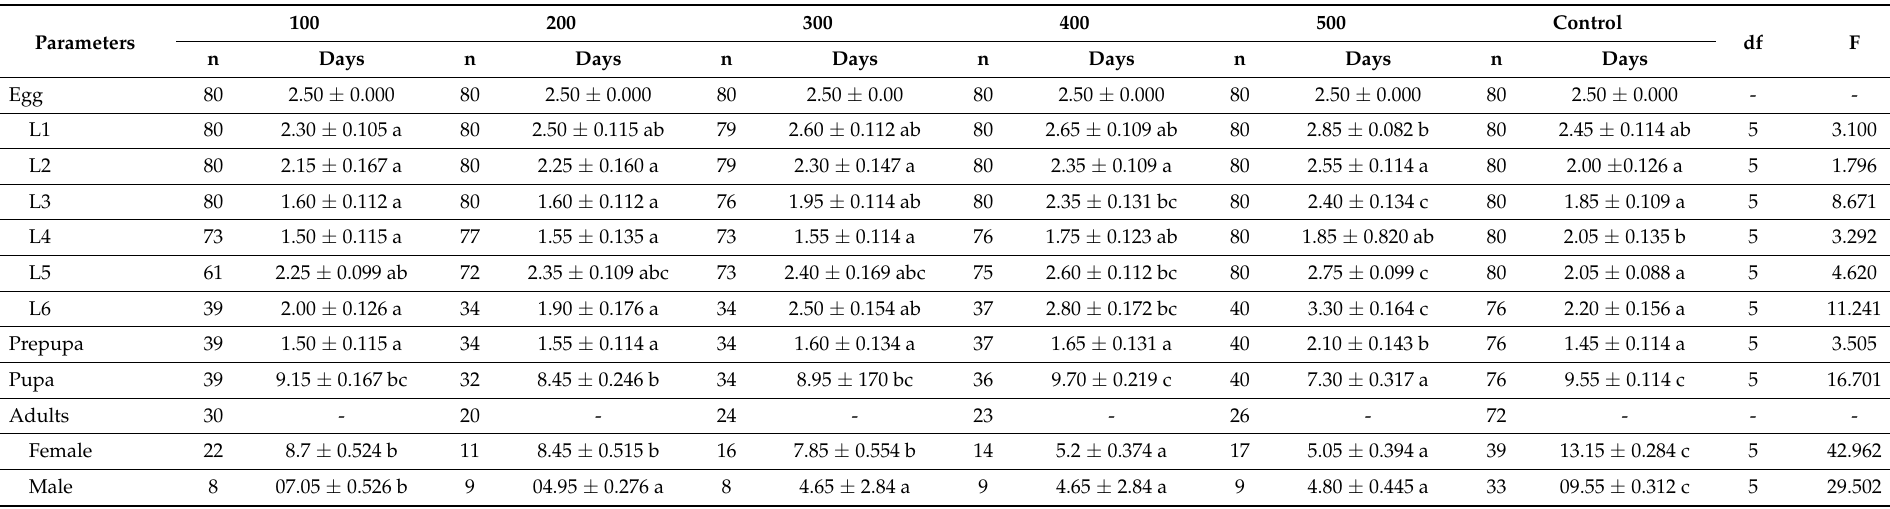
Table 1. Development time and adult longevity (Mean ± SE) of FAW fed on dip food (baby-corn) in ZnO NPs difference concentrations (100–500